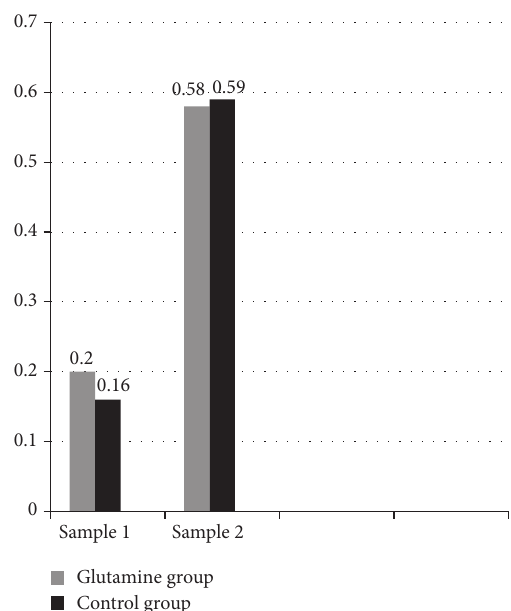
Figure 2: Serum glutamine levels (mM) in sample 1 and sample 2 in glutamine and control